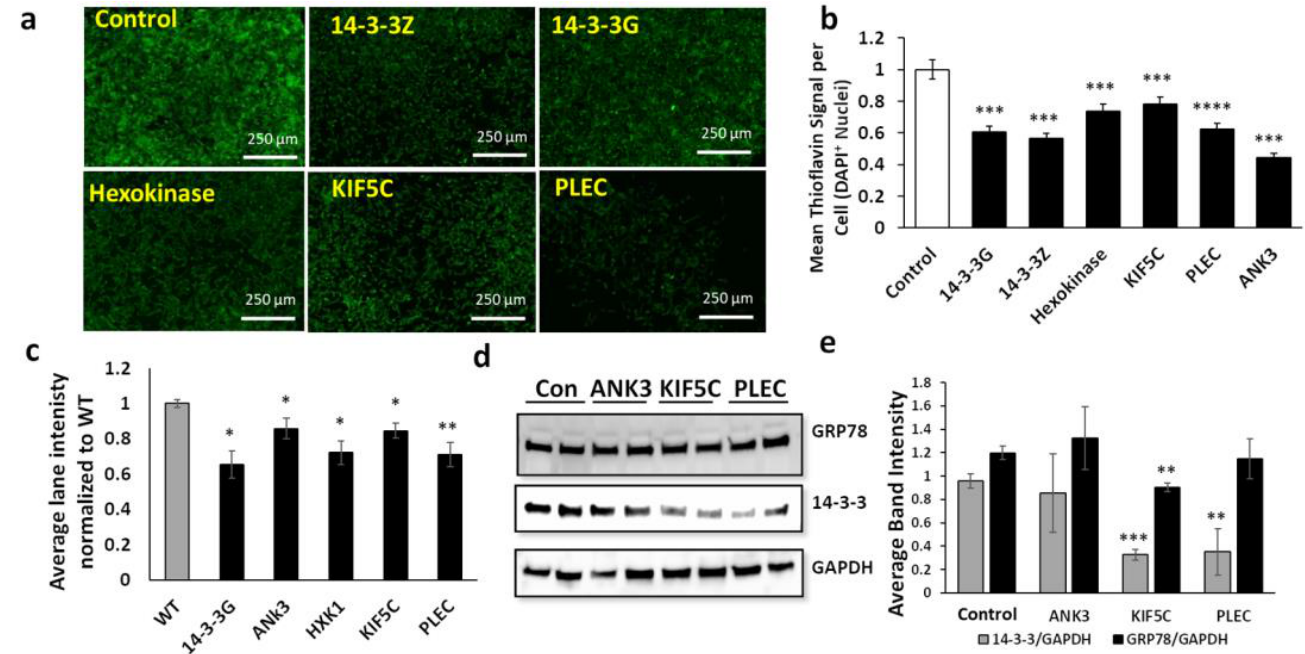
Figure 2. SiRNA knockdowns of influential aggregate hubs reduce aggregation in human cells. ( a ) Fluorescence images of thioflavin T-stained SH-SY5Y-APP Sw cells after liposomal transfection with siRNA constructs targeting 14-3-3 paralogs or their interacting partners. ( b ) Histogram of means ± SEM for Thioflavin T staining of amyloid as in ( a ). ( c ) Intensity of SYPRO-Ruby-stained gel lanes for sarkosyl-insoluble aggregates isolated from SY5Y-APP Sw cells exposed to RNAi constructs; ( d ) western blot probed with antibody to GRP78, 14-3-3, or GAPDH; gels were loaded with total pro- tein extracted from SH-SY5Y-APP Sw cells treated with RNAi constructs indicated; ( e ) mean ± SEM of band intensity for 14-3-3 or GRP78, each normalized to GAPDH. ( b , c , e ) Significance based on two-tailed t-tests: * p < 0.05; ** p < 0.005; *** p < 10 – 7 ; **** p < 10 – 17 . For each assay, 100 < N < 150.